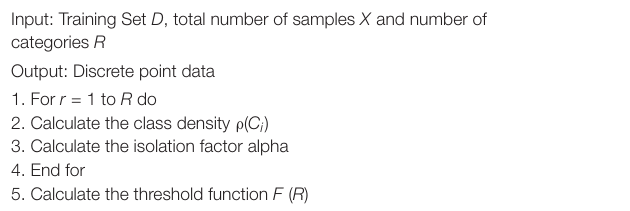
ALGORITHM 1 | The specific construction method.